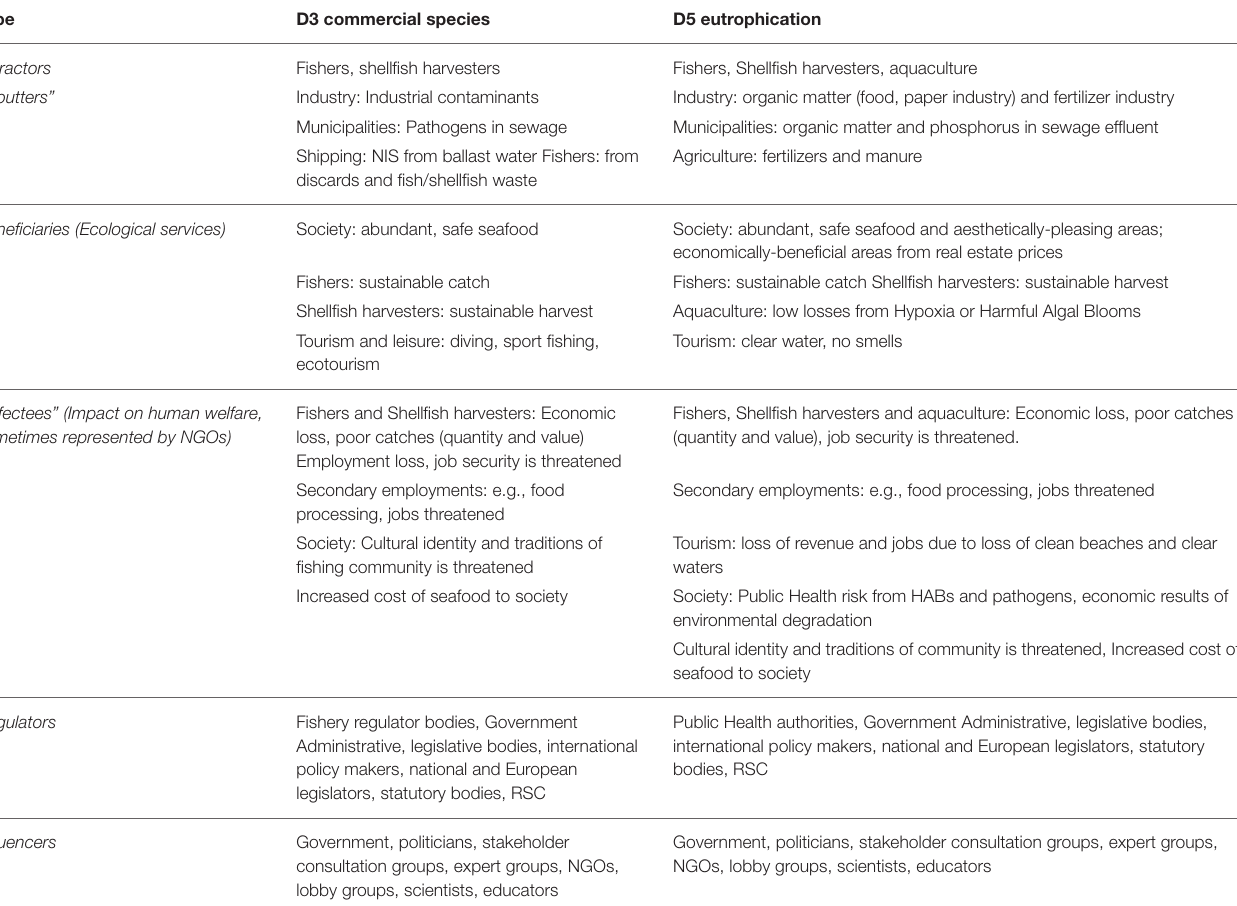
TABLE 3 | Example of typology of MSFD stakeholders for Good Environmental Status Descriptor 3 (commercial species) and Descriptor 5 (eutrophication).